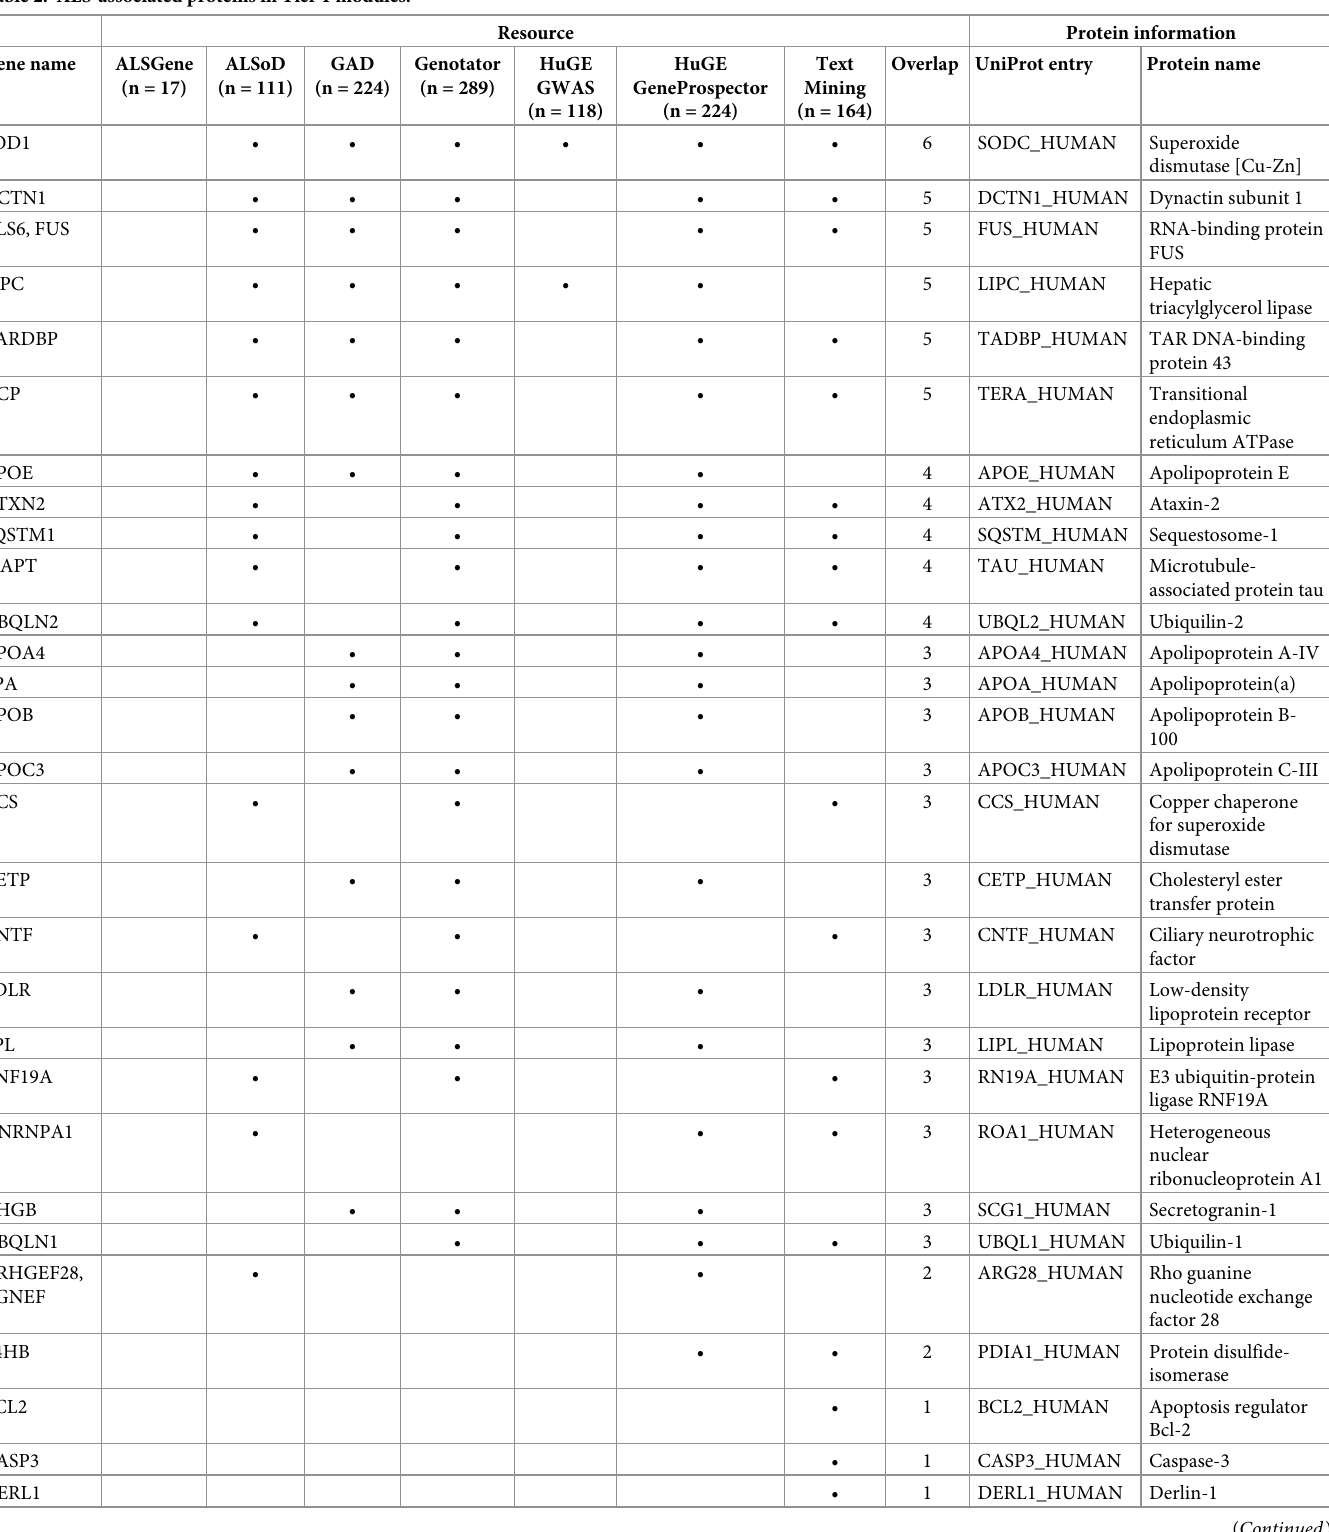
Table 2. ALS-associated proteins in Tier 1